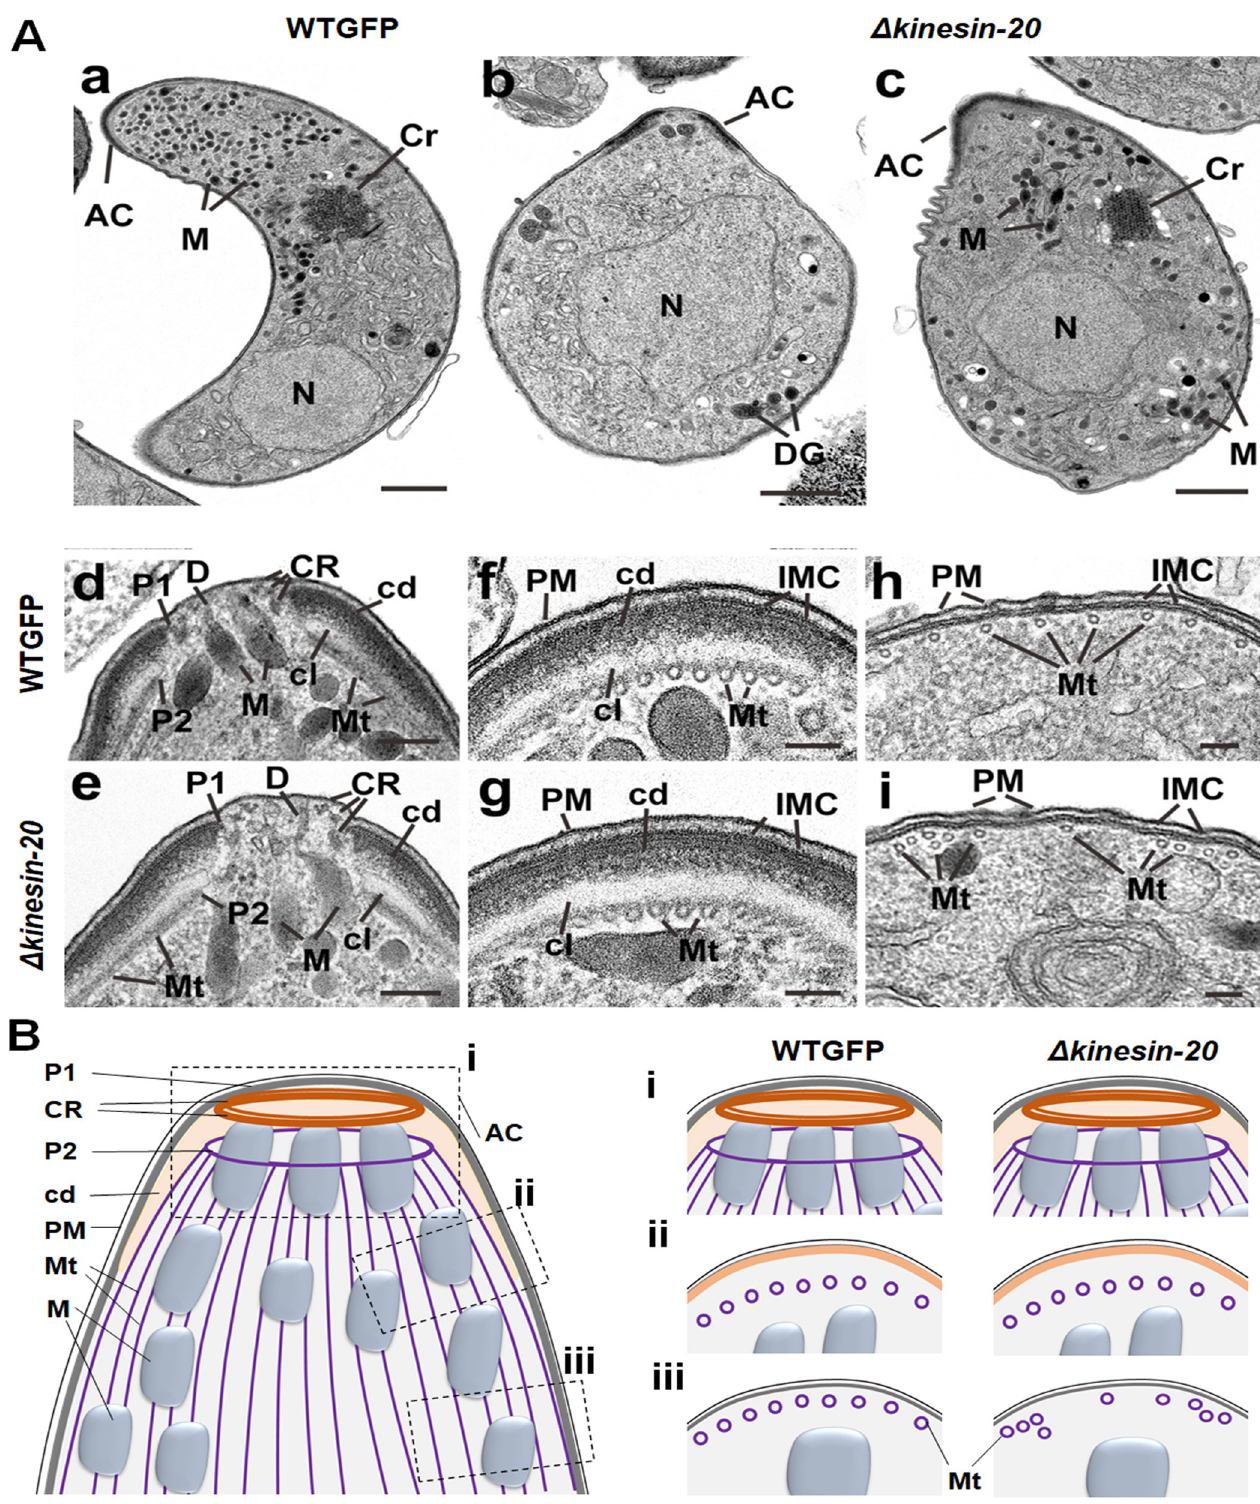
Fig 4. Ultrastructural analysis of WTGFP and Δ kinesin -20 ookinetes. (A) Electron micrographs of WTGFP (a, d, f, h) and Δ kinesin-20 (b, c, e, g, i) ookinetes. Bars represent 1 μ m (a-c) and 100 nm (d-i). (a) Longitudinal section of a crescentic shaped WTGFP ookinete showing the apical complex (AC) with numerous micronemes (M) in the anterior cytoplasm and a more posteriorly located crystalline body (Cr) and nucleus (N). (b) Longitudinal section through an immature Δ kinesin-20 ookinete displaying a bulbous shape. Within the cytoplasm, the AC plus an irregular shaped N and a few irregularly arranged dense granules (DGs) can be identified. (c). Longitudinal section through a more mature Δ kinesin-20 ookinete showing a bulbous shaped cell. Within the cytoplasm, the AC, N, and